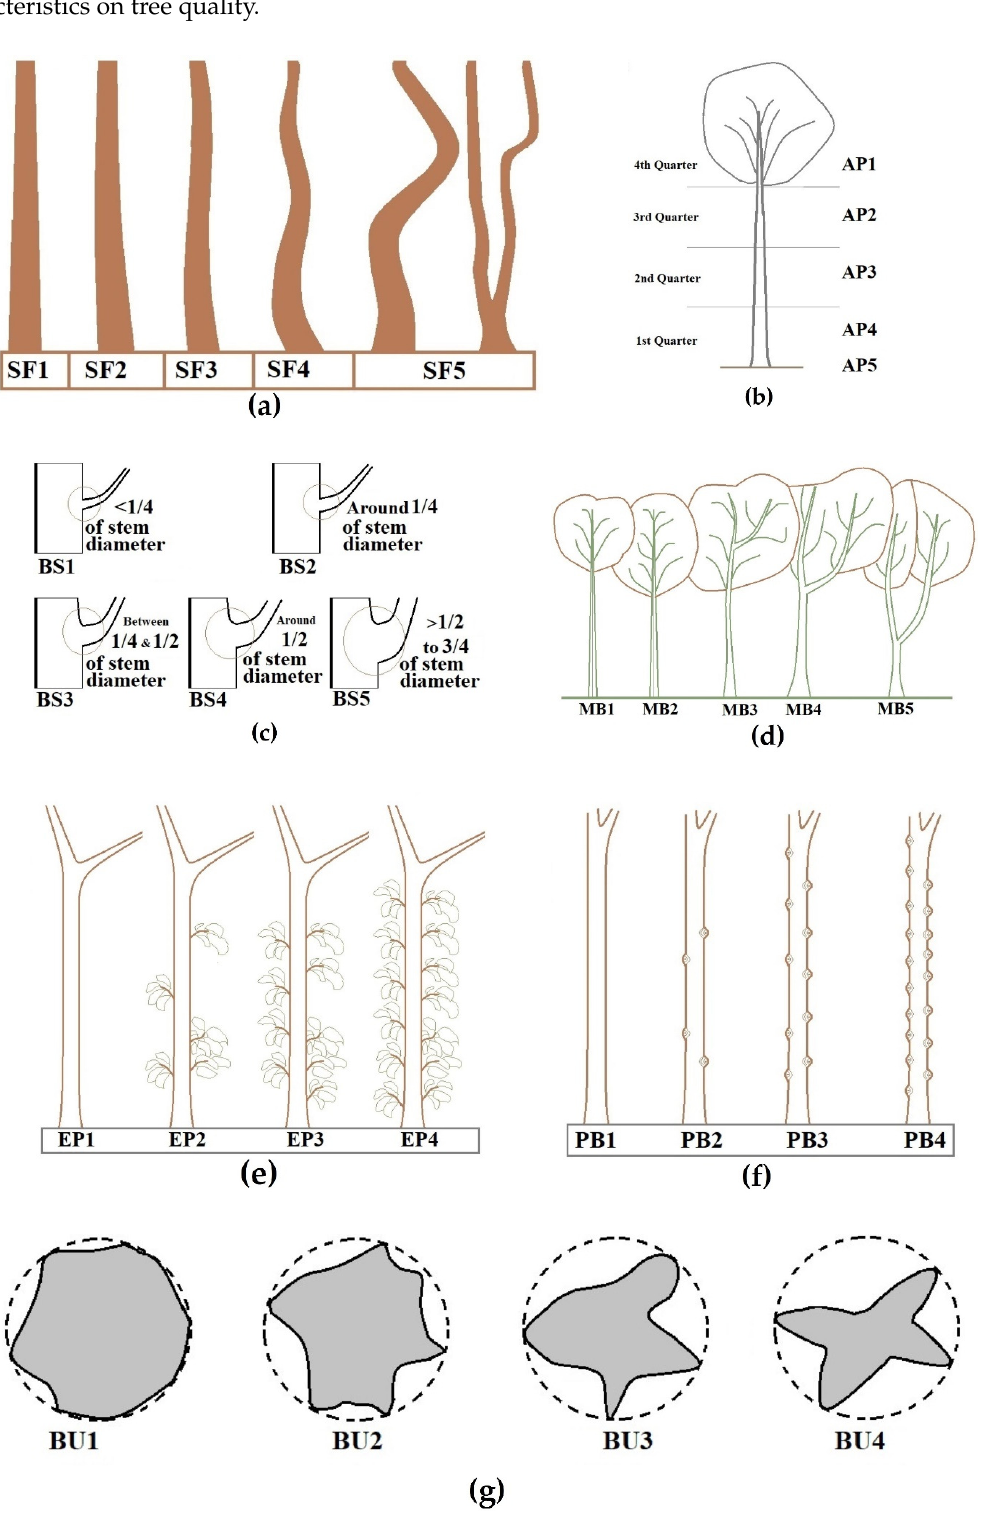
Figure 2. Scoring for tree quality assessment. ( a ) Stem form (SF) modified from Keiding et al. [34]. ( b ) Axis persistence (AP) modified from Kjaer et al. [30]. ( c ) Branch size (BS). ( d ) Mode of branching (MB) modified from Keiding et al. [34]. ( e ) Epicormic shoots (EP). ( f ) Protuberant buds (PB). ( g ) Buttressing (BU) modified from Kjaer et al.